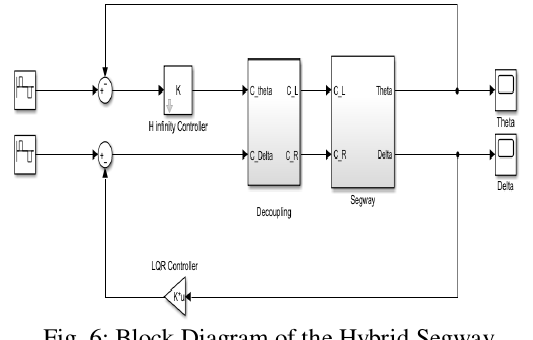
Fig. 6: Block Diagram of the Hybrid Segway